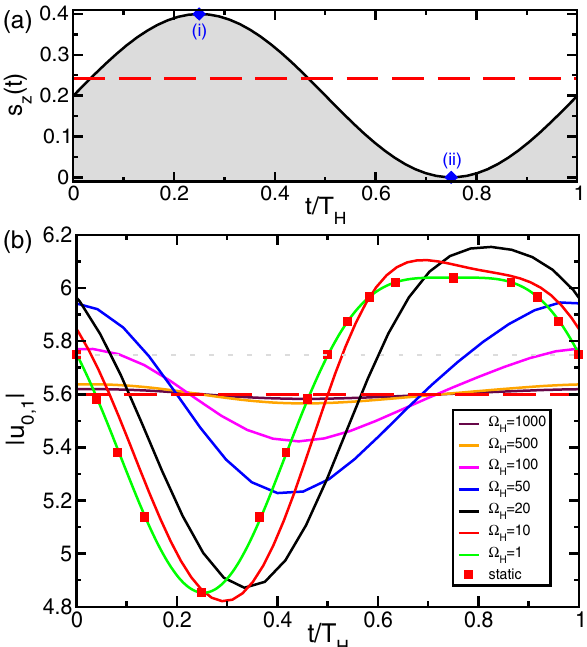
Figure 4. Supercritical TVF in magnetic fields with different driving frequencies (cid:31) H . ( a ) Temporal oscillations of the control function s z ( t ) = s z , S + s z , M sin (� h t ) ( s z , S = 0.2, s z , M = 0.2 ). ( b ) The dominant mode amplitude | u 0,1 | as a function of the reduced time t / T H ( T H = 2 π/� H being the modulation period associated with the corresponding frequency). The red squares show the stationary response to stationary magnetic field with magnetic field strength s z given by the actual value of s z ( t ) . The dashed red lines show the order parameter for stationary driving with the mean Niklas parameter � s z ( t ) � = 0.245 . Further control parameter Re = 100